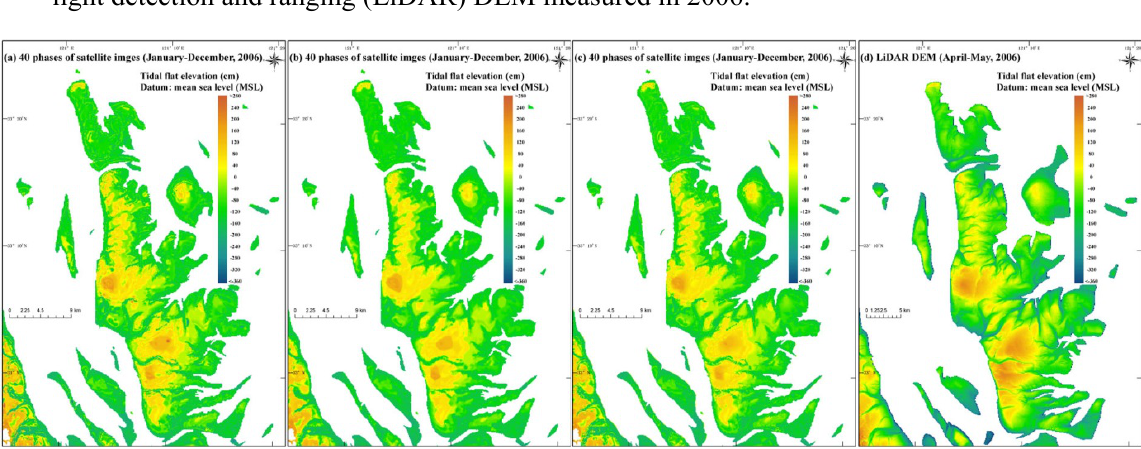
Figure 3. DEMs of the Dongsha Sandbank in 2006 from different